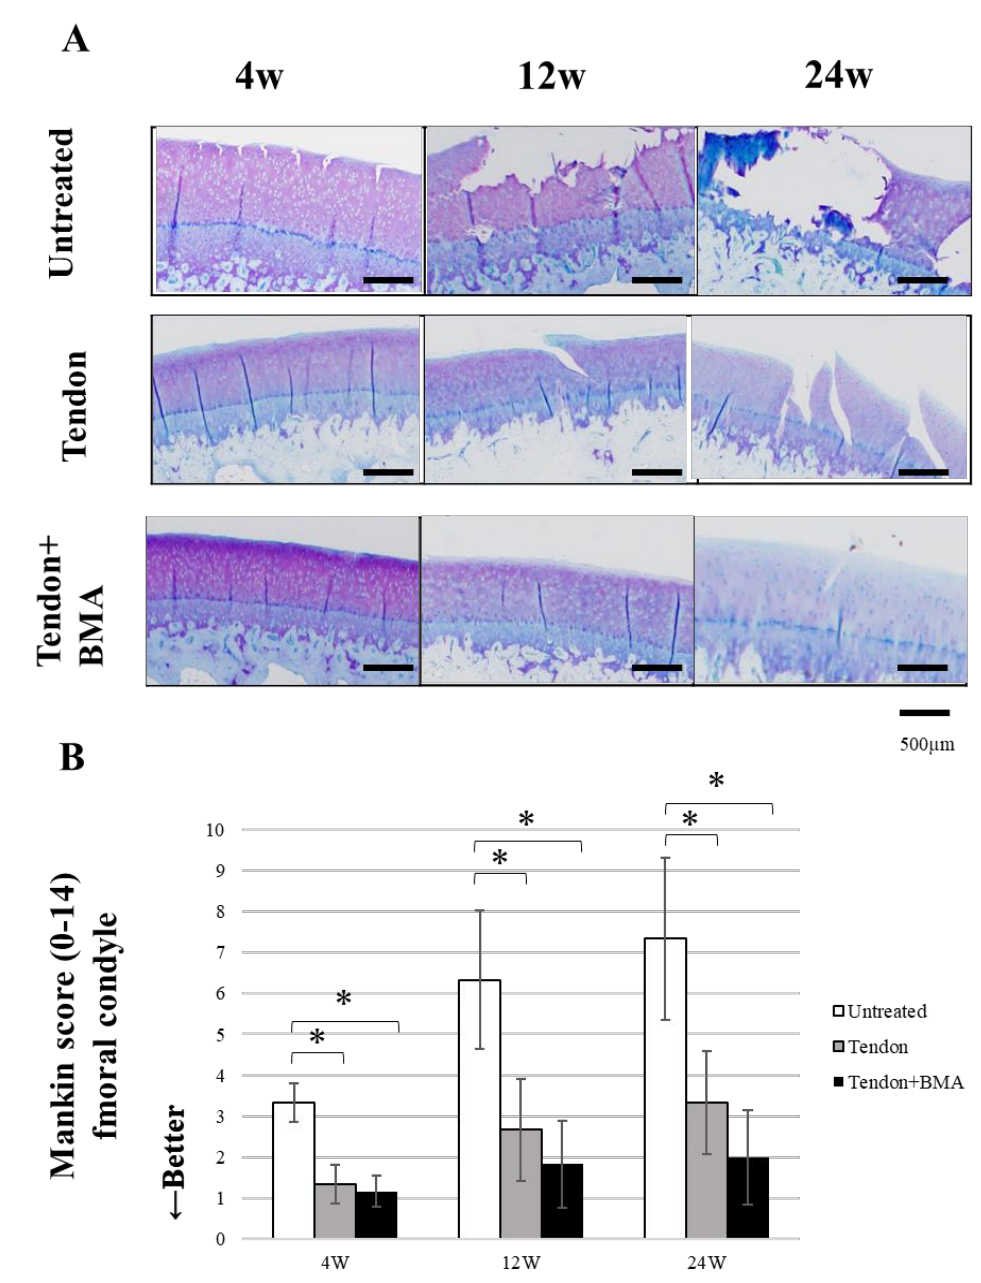
Figure 5. Histological analyses for articular cartilage at the medial femoral condyle. ( A ) Toluidine blue staining of medial femoral condylar cartilage. ( B ) Mankin score. ( n = 6, * p < 0.05). The Mankin score in the tendon and tendon + BMA groups was significantly lower than that in the untreated group.